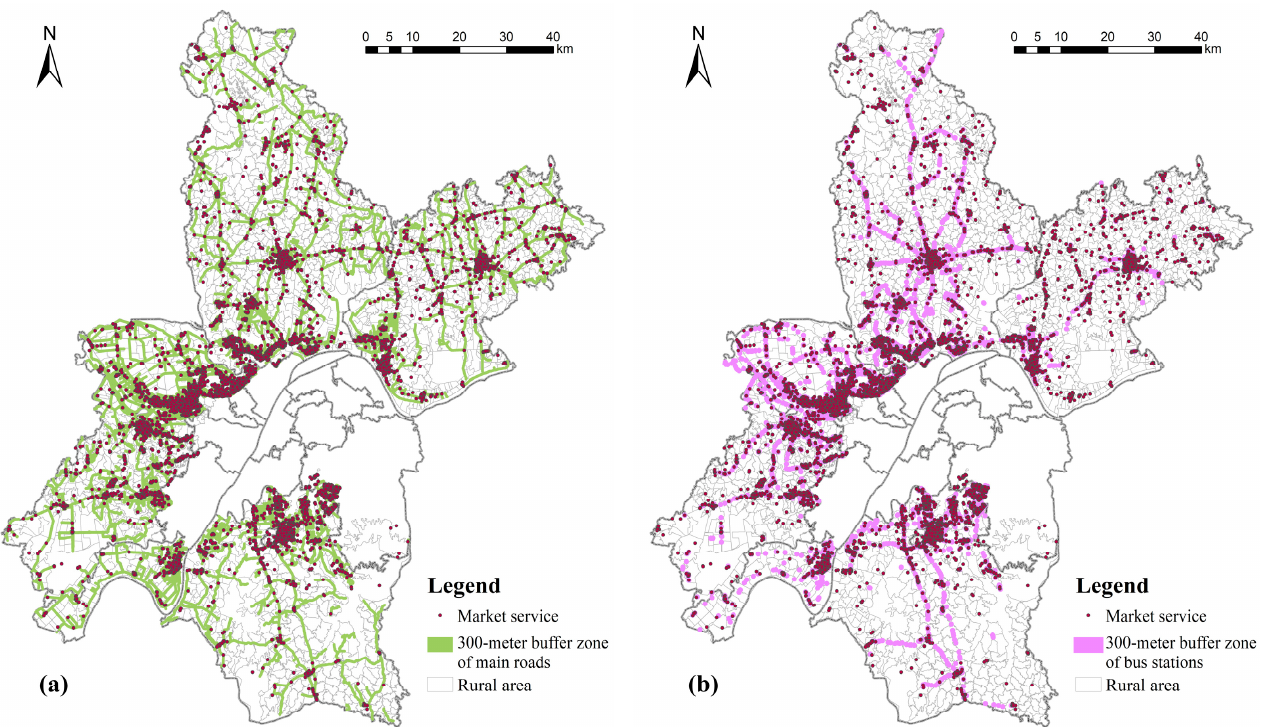
Figure 9. The relationship between the distribution of market service industry and transportation conditions: ( a ) main roads; ( b ) bus stations.